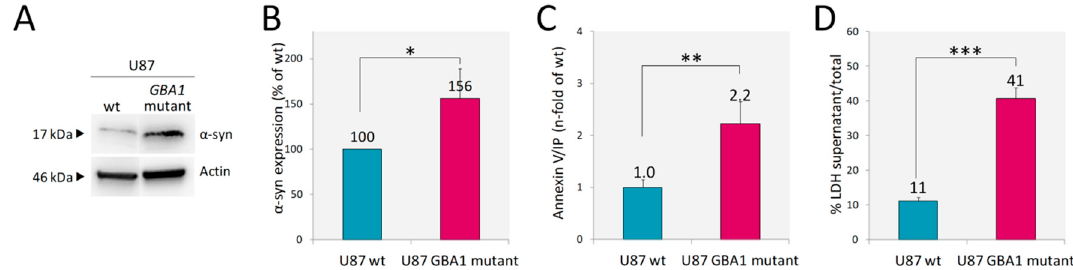
Figure 4. Accumulation of α -synuclein and cell death. The higher α -syn abundance shown by the U87 GBA1 mutant by WB analysis ( A ). Quantification of α -syn signals normalized to actin ( B ) showed that mutant cells displayed a 56% increase in α -syn content. This increment was accompanied by an increased percentage of apoptotic cells as assessed by Annexin V positive and propidium iodide (IP) negative ( C ) and LDH activity release ( D ). Results are expressed as mean ± SD of three independent experiments. * p < 0.05, ** p < 0.001, *** p < 0.0001.